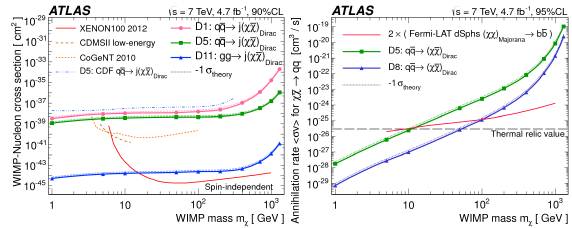
Figure 5: Upper limits on σ SI (left) and σ 2 γ v (right) inferred from monojet+ E miss ATLAS data [57]. T